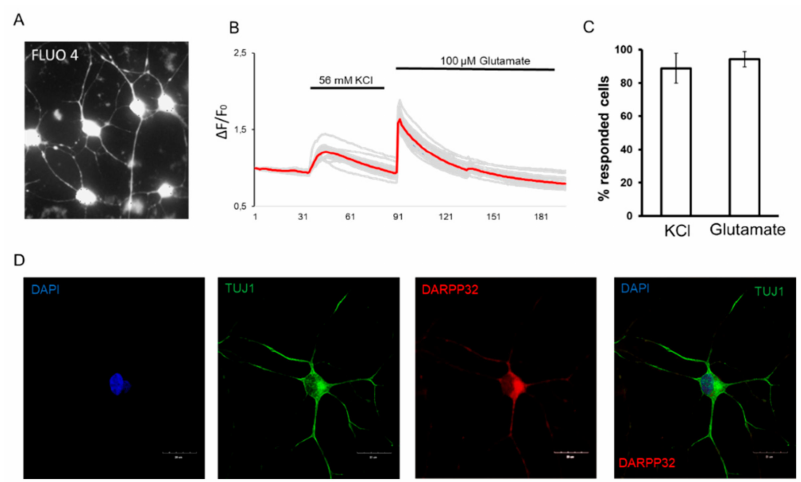
Figure 3. Functional assay study for reprogrammed iSNs. ( A ) Representative image of reprogrammed iSNs loaded with Fluo-4. ( B ) Cytosolic calcium cation levels in reprogrammed iSNs in response to depolarization of the plasma membrane with 56 mM potassium chloride (KCl) and 100 µ M glutamate solution. Black lines on the top of the graph indicate the moment of application of 56 mM KCl and 100 µ M glutamate solution to the cells. The gray curves illustrate the response of an individual cell in the field of view. The red curve illustrates the average response of cells. ( C ) Histogram represents the number of the responding cells with stimulation of 56 mM KCl and 100 µ M. The number of responding cells was calculated by determining the number of cells that showed >10% increase in fluorescence intensity compared to that of the baseline. n > 50 cells for each solution. ( D ) Representative image illustrated morphology of iSN. Microphotographs of the iMSN obtained with the optimized protocol. Immunofluorescent staining of cells with DAPI, antibodies for TUJ1 (secondary antibodies Alexa 488), DARPP32 (secondary antibodies Alexa 555), and composite image. Confocal microscopy, × 60. The scale bar corresponds to 20 µ